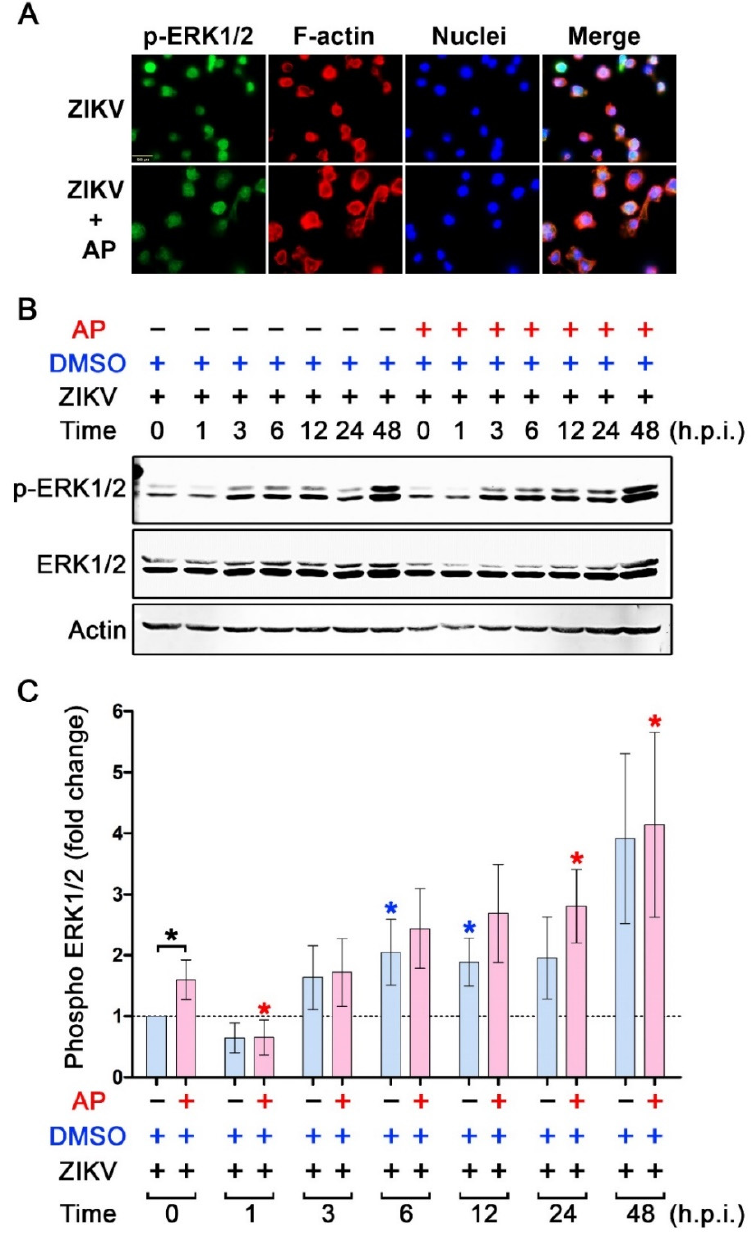
Figure 8. Effects of AP on the activation status of pERK1/2 kinase in THP-1 macrophages infected with ZIKV. ( A ) Immunofluorescence study detecting the presence of phosphorylated ERK1/2 kinase (p-ERK1/2) (green) in the nucleus of THP-1 macrophages infected with ZIKV at MOI 5 for 24 h. F-actin (red) was stained with DyLight TM 594-Phalloidin, and nuclei of cells (blue) were stained with DAPI. Scale bar = 500 µ m. ( B ) Western blot analysis detecting p-ERK1/2 kinase, total ERK1/2 kinase (ERK1/2), and actin in the lysates of THP-1 macrophages infected with ZIKV at 5 MOI with or without post-treatment with 6.25 µ M of AP at various time points (0–48 h). ( C ) Densitometric quantification of p-ERK1/2 immunoreactive bands versus total ERK1/2 in the lysates of THP-1 macrophages infected with ZIKV at 5 MOI with or without post-treatment with 6.25 µ M of AP at various time points (0–48 h). Actin was used as an internal control. * p < 0.05 (red asterisk (compared to the AP-treated group at 0 h), blue asterisk (compared to the DMSO-treated group at 0 h), and black asterisk (compared between AP-treated group and DMSO control group at each time point)). h.p.i. = hour(s) post-infection. Densitometry scans and uncropped blots are presented in Supplementary